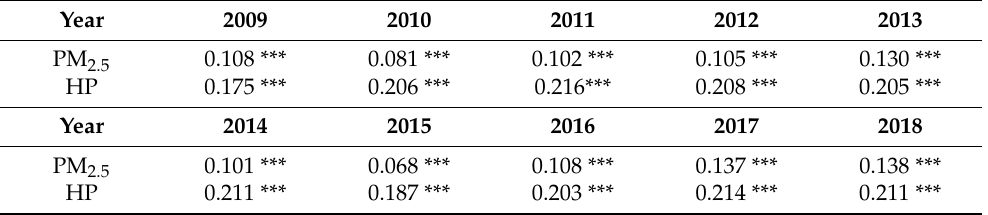
Table 2. Results of the Moran test.